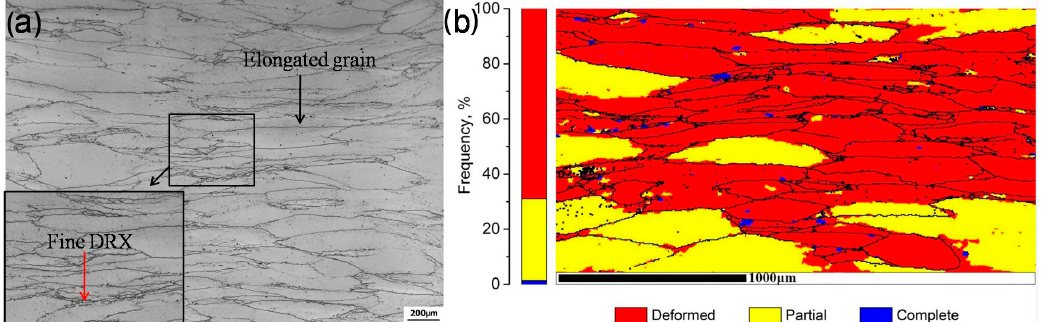
Figure 12. ( a ) microstructure; ( b ) recrystallized fractions of Domain 3 at the true strain of 0.7.